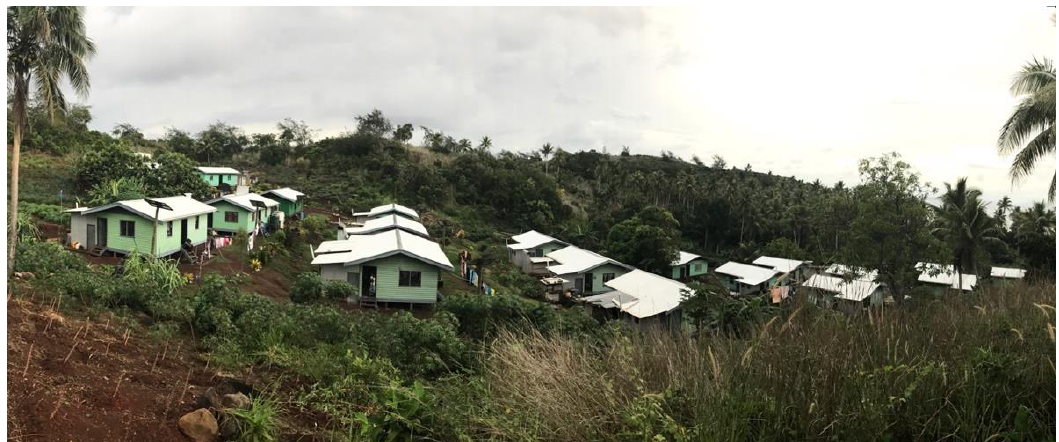
Figure 3. The new village relocation site of Denimanu.